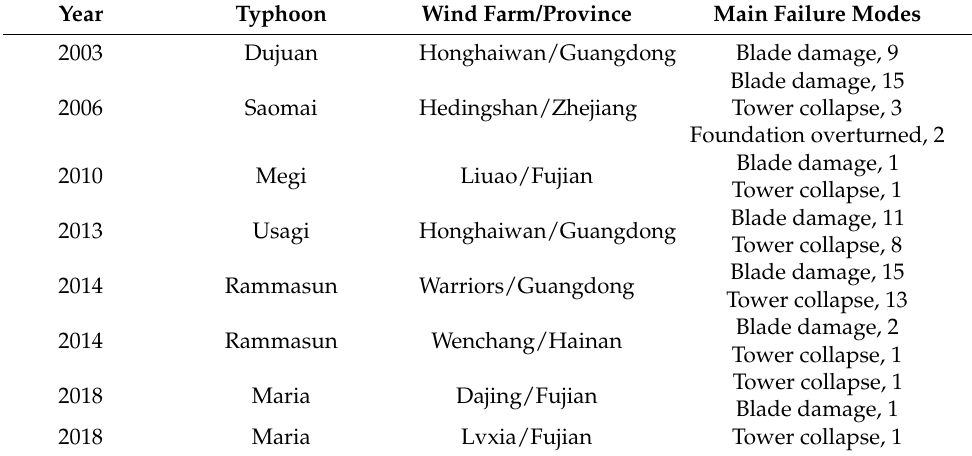
Table 2. Structural failures of wind turbines caused by typhoons in recent